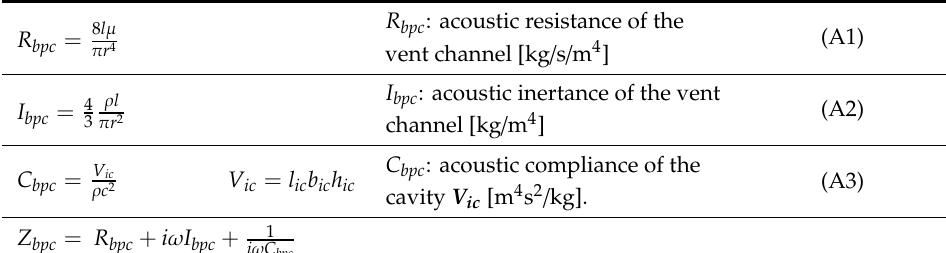
Table A1. Lumped parameter model for the acoustic impedance Z bpc of the system for static pressure equalization (SPEQ) [kg / s / m 4 ], [23].